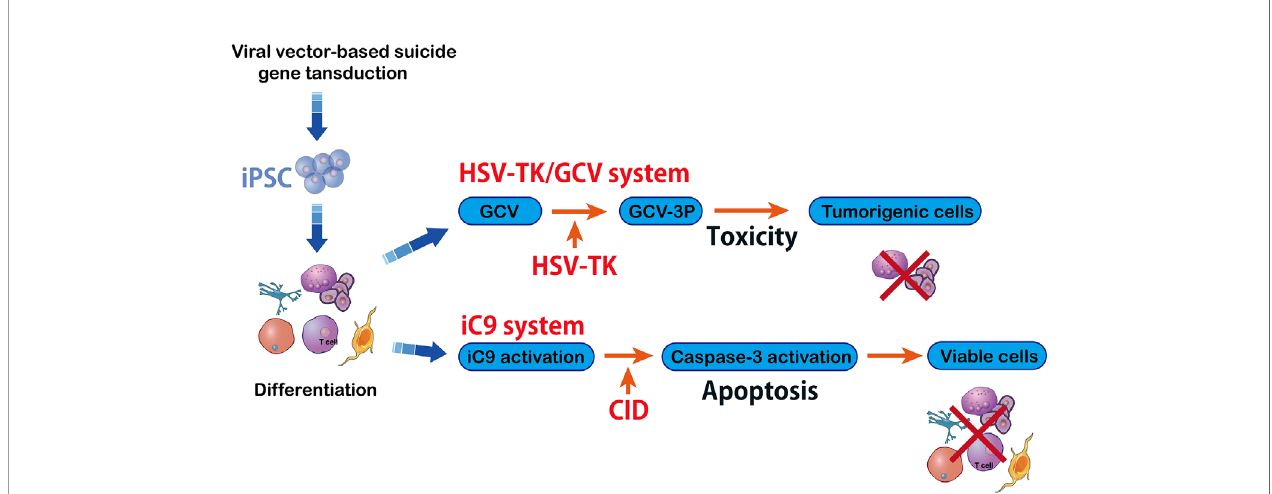
FIGURE 5 | HSV-TK/GCV system vs inducible caspase-9 system. The herpes simplex virus – Thymidine Kinase/ganciclovir (HSV-TK/GCV) system eliminates tumorigenic cells and it is ef fi cient and speci fi c against inducible pluripotent stem cells (iPSC) that can kill the cells whose HSV-TK expression has been silenced. The HSV-TK/GCV system is used as a safety switch and it produces a toxic compound that kills the transduced cells. Another method in suicide gene therapy is introducing inducible caspase-9 (iC9) into iPSC. The iC9 dimerization activates iC9 which then triggers a caspase cascade leading to elimination of tumors originating from iPSC. Speci fi c chemical inducers of dimerization (CID) induce